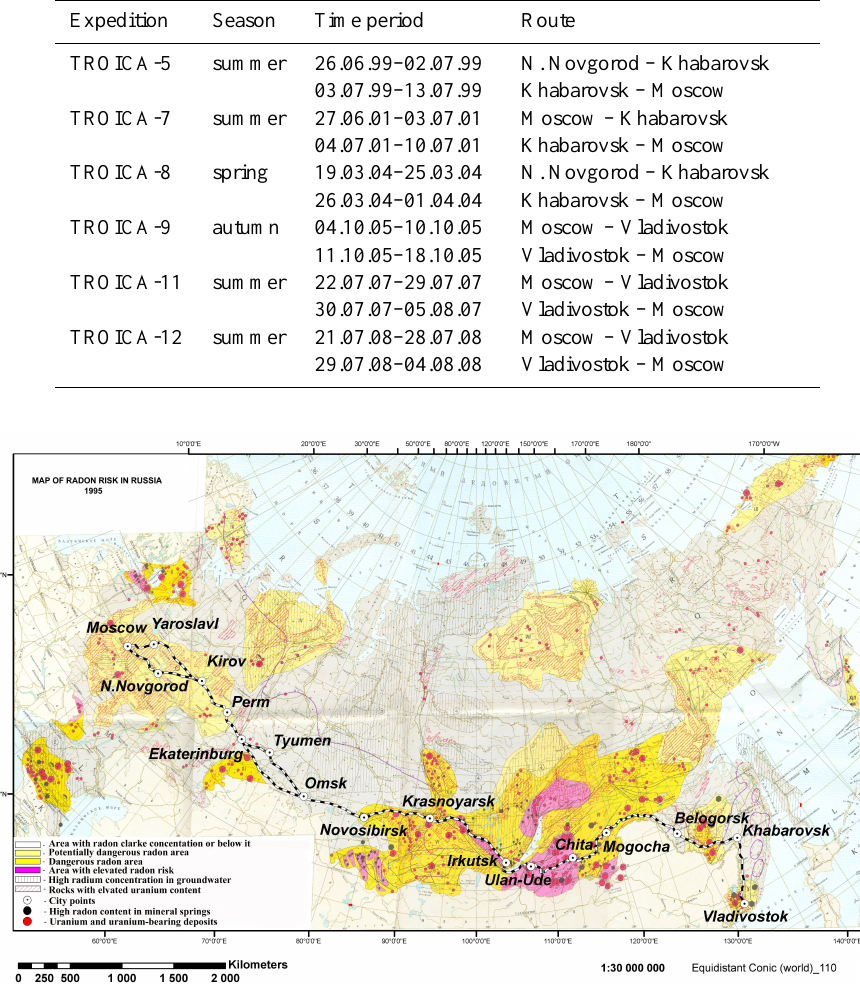
Fig. 1. Map of radon risk of Russia and the TROICA expeditions route along the Trans-Siberian Railway from Moscow to Vladivostok.